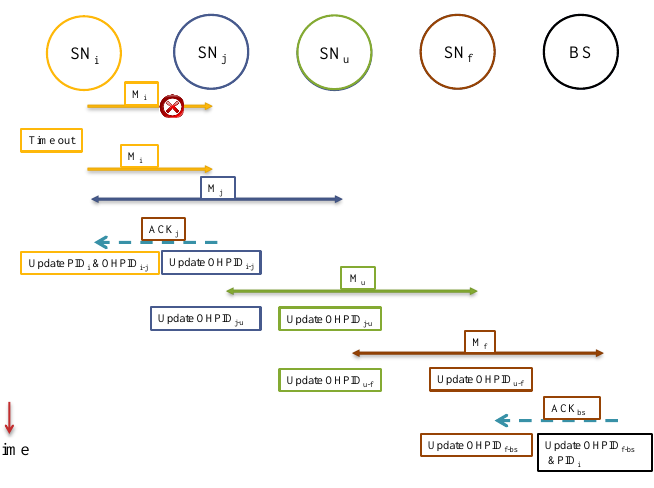
Figure 5. Acknowledgement for a message with errors.